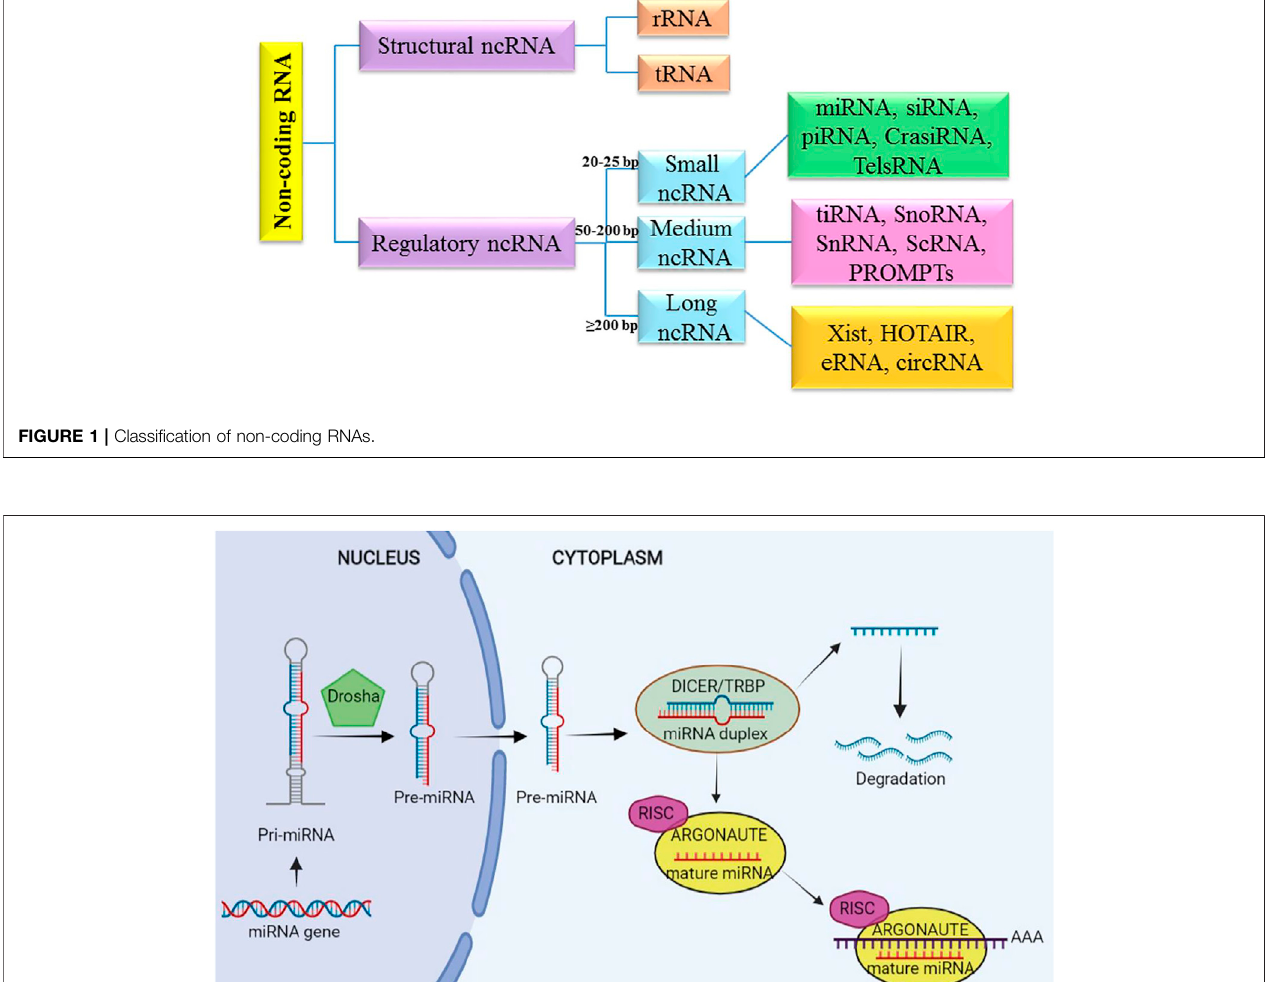
Frontiers in Cell and Developmental Biology |